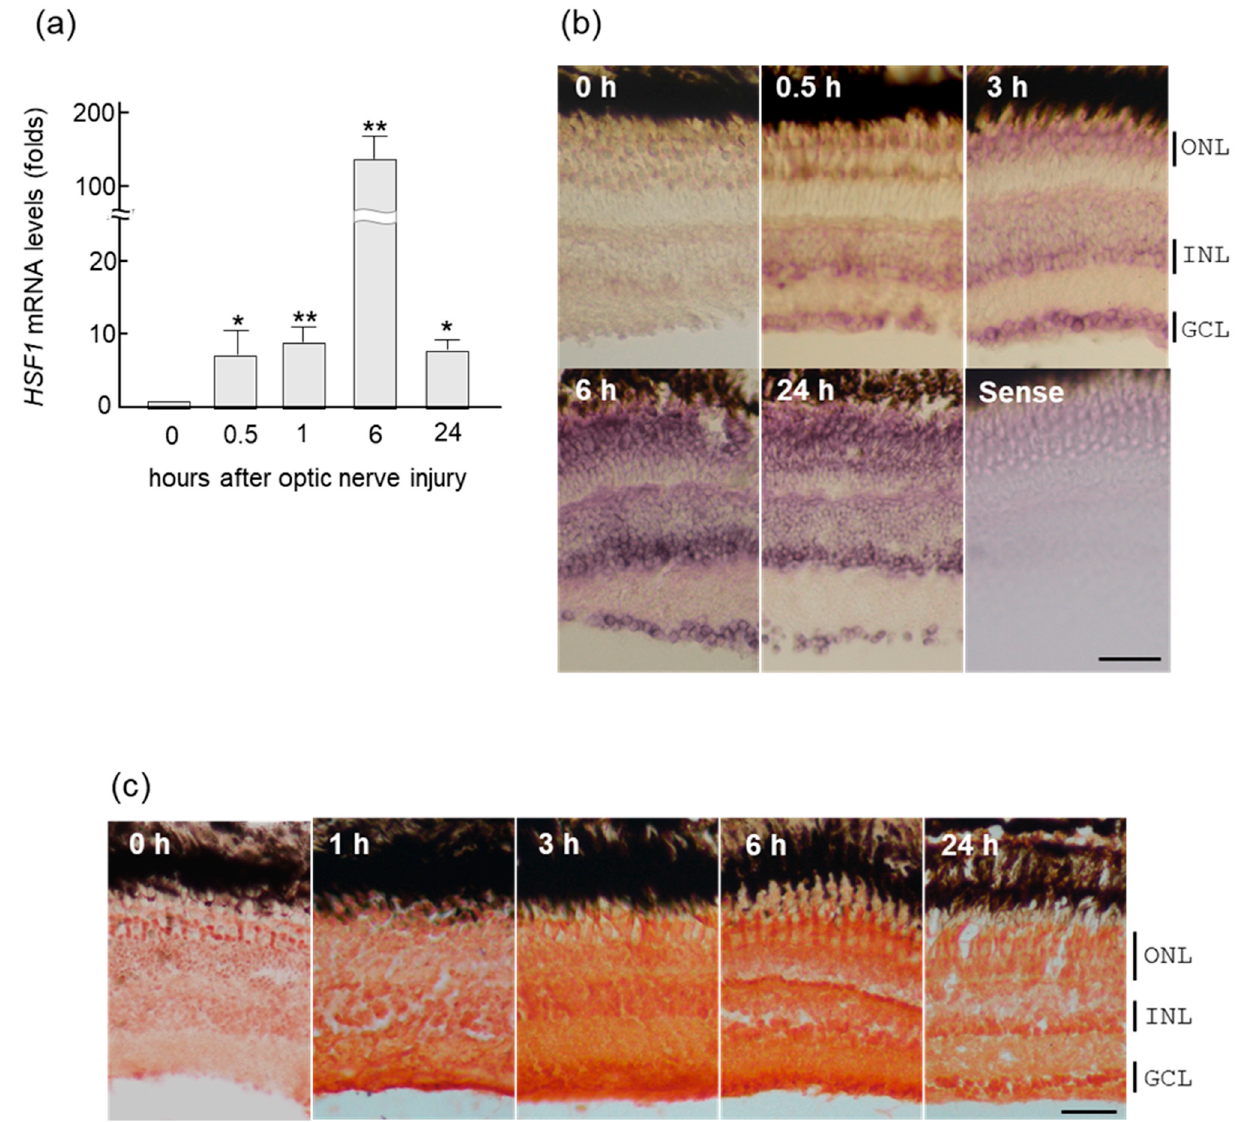
Figure 1. Upregulation of HSF1 (heat shock factor 1) mRNA in zebrafish retina after ONI (optic nerve injury). ( a ) HSF1 mRNA expression levels after ONI were determined using quantitative real-time PCR. ( b ) In situ hybridization of HSF1 in the zebrafish retina after nerve injury. HSF1 mRNA started to increase in the retina for 0.5 h and peaked at 6 h after ONI. Its localization was first seen in the GCLs (ganglion cell layers) and after the INLs (inner nuclear layers). Then, these signals spread to all nuclear layers including the ONLs (outer nuclear layers) at 6 h and slightly decreased at 24 h after ONL. ( c ) Immunohistochemical staining of HSF1 in the zebrafish retina after ONI. Significant immunostaining peaked at 3 to 6 h in all nuclear layers after ONI. Data are expressed as the mean ± SEM of five independent experiments and analyzed by one-way ANOVA, followed by Scheffe’s multiple comparisons. Statistical significance was set at * p < 0.05 or ** p < 0.01. Scale bar = 50 µ